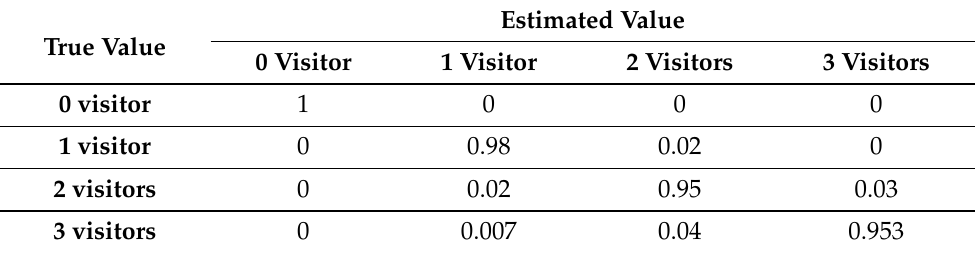
Table 2. Confusion matrix of people